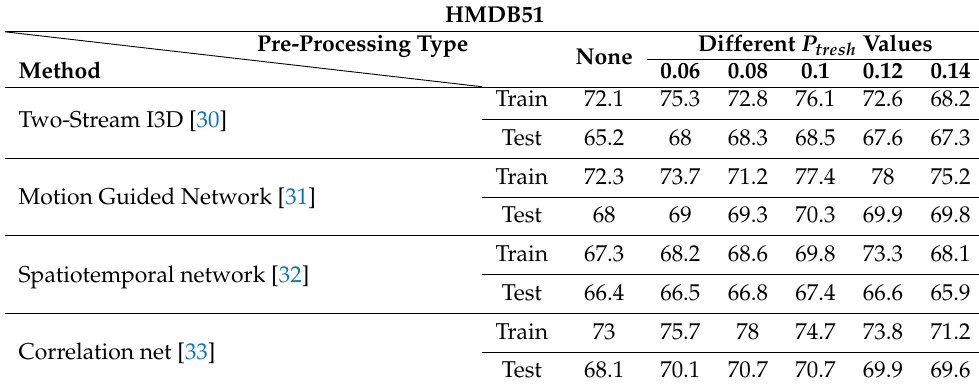
Table 4. Accuracy of the Train and Test data in UCF101 dataset in Different P tresh values. Method